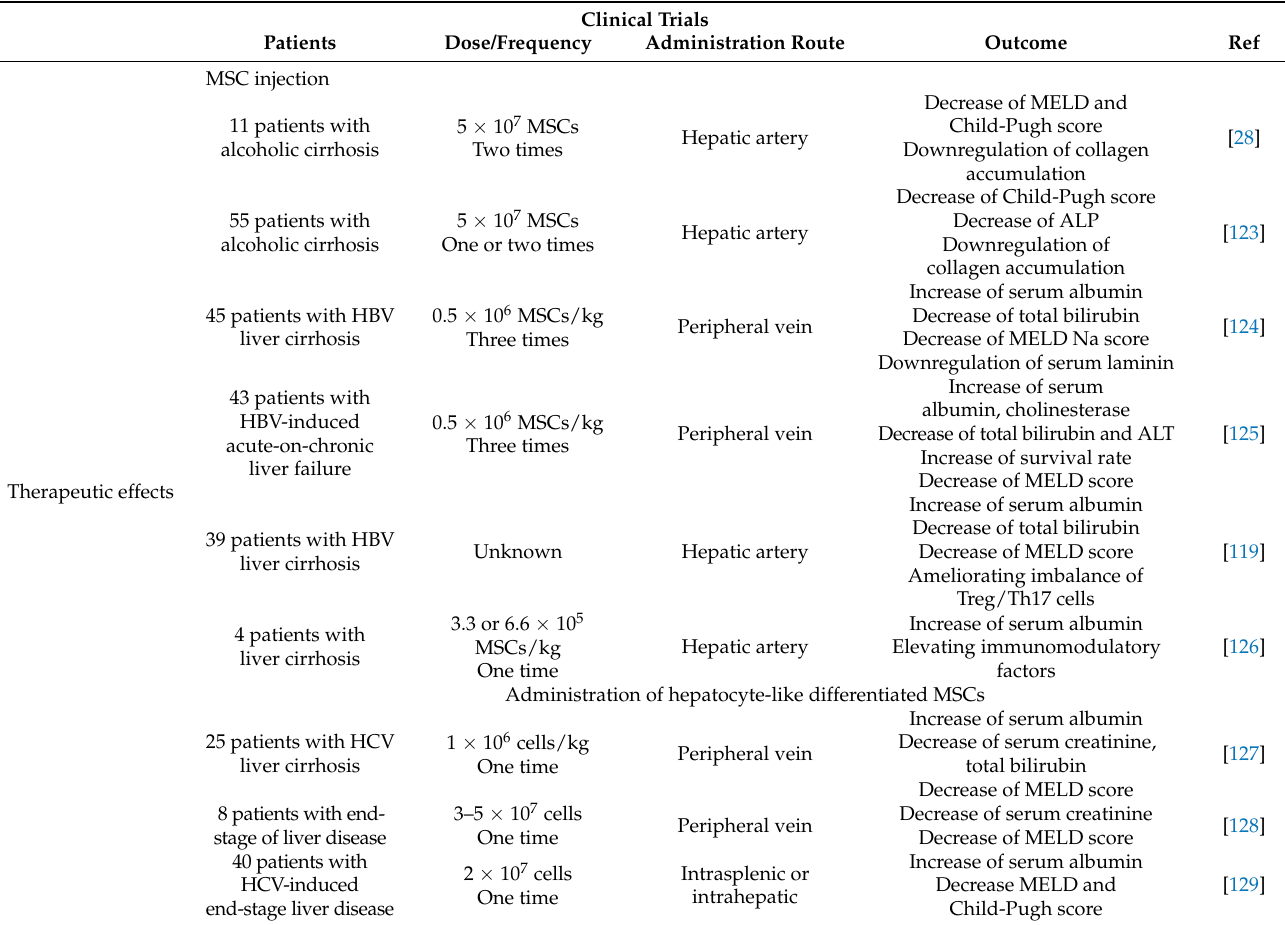
Table 2. Summary of clinical trials using MSCs for liver